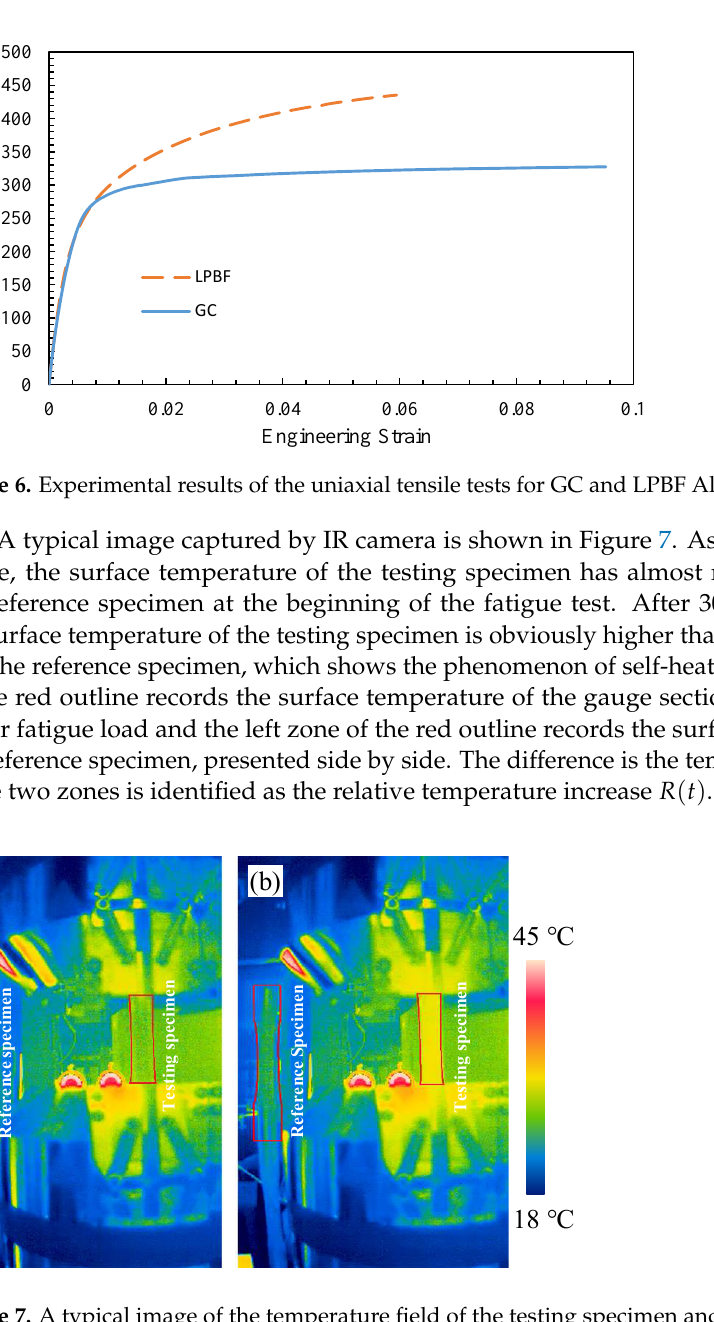
Figure 7. A typical image of the temperature field of the testing specimen and reference specimen: ( a ) temperature field at the beginning of the test; ( b ) temperature field after 3000